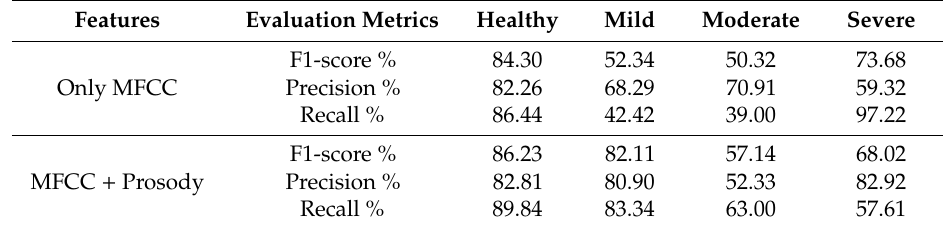
Table 10. Evaluation metrics for all severity groups using an NN